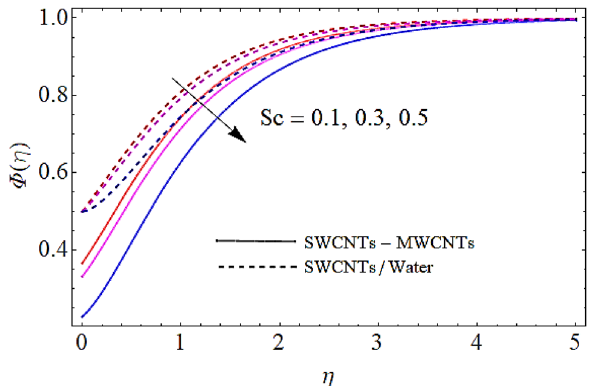
Figure 12. Concentration profile versus Sc when M = 0.5, φ 1 = φ 2 = 0.02, K = 0.7, Pr = 12 .